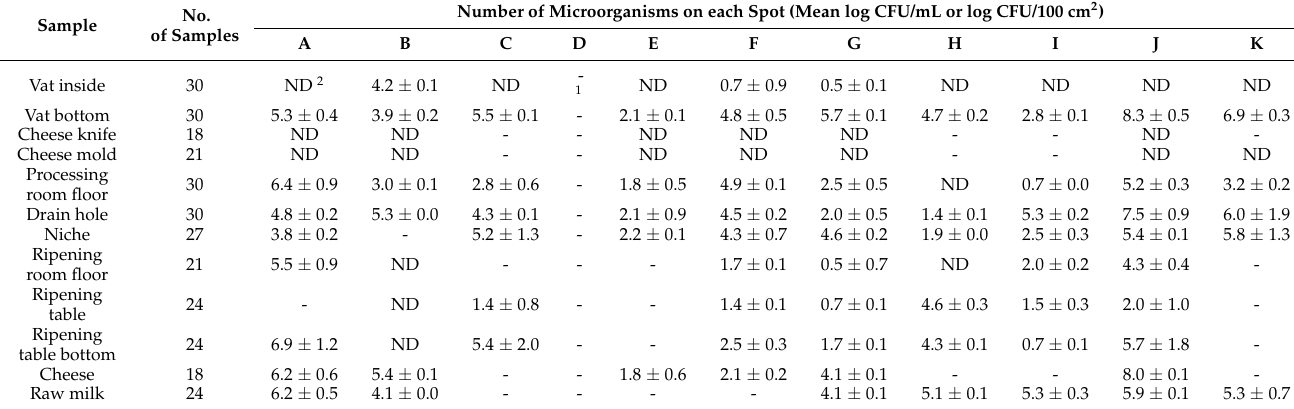
Table 3. Mean ( ± SD) total aerobic bacteria counts in the processing plants of each dairy farm (A to K). No. Sample of